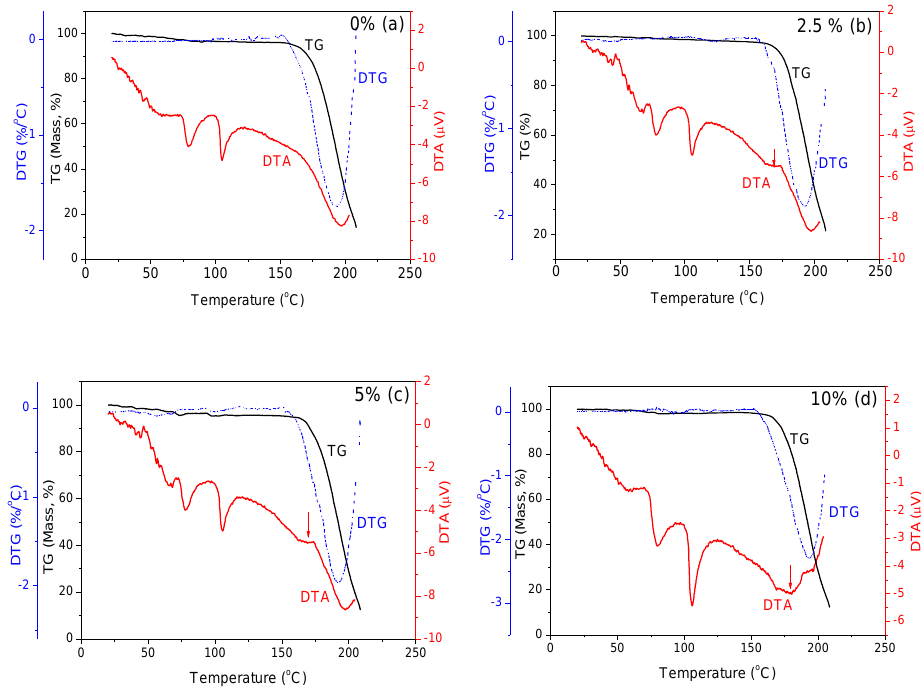
Figure 4. TG, DTG, and DTA curves of ( a ) TBA-Br with Al 2 O 3 additive at concentration of ( b ) 2.5, ( c ) 5, and ( d ) 10 wt %.